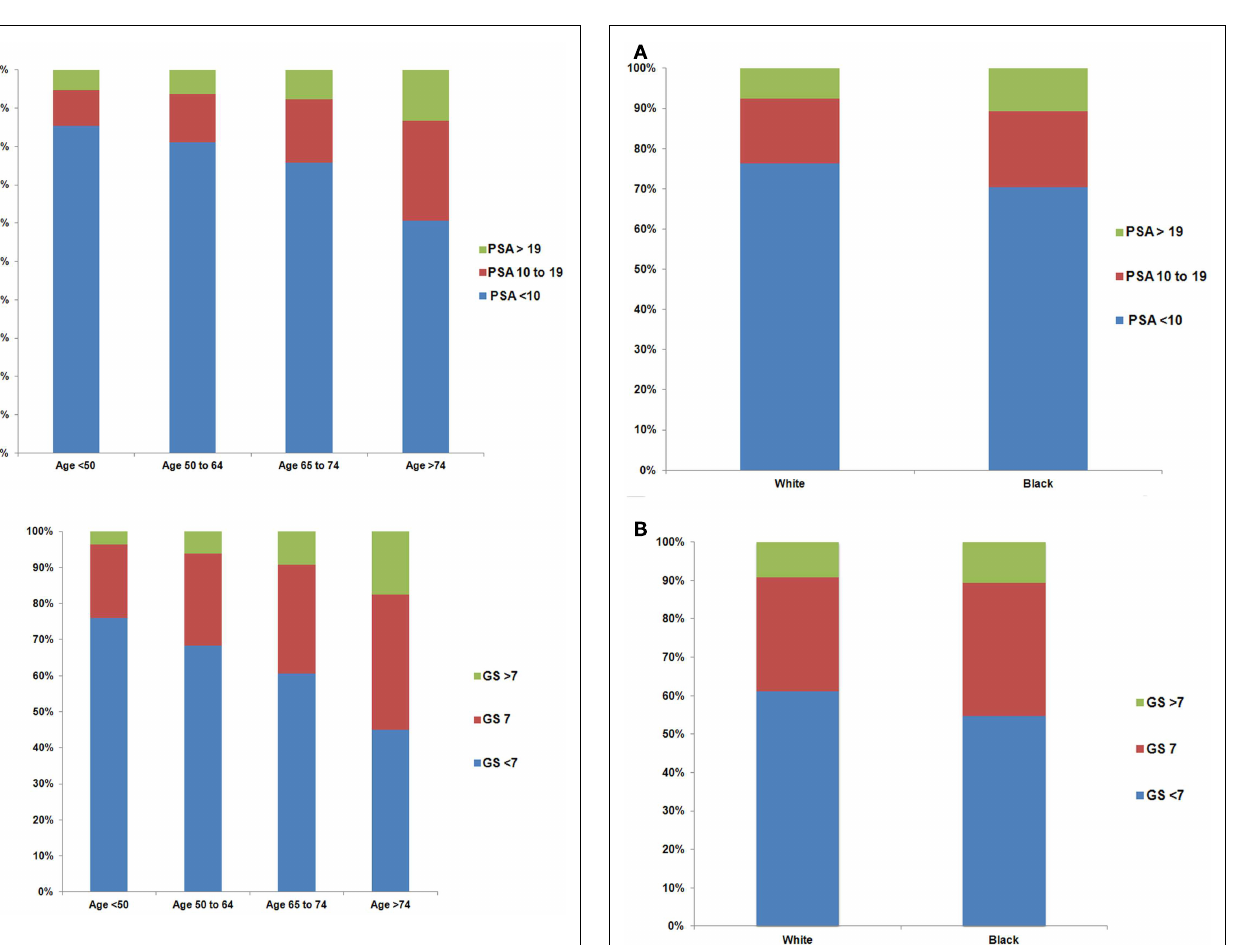
difference in GS profile between black and white men ( Figure 2B , p < 0.01).